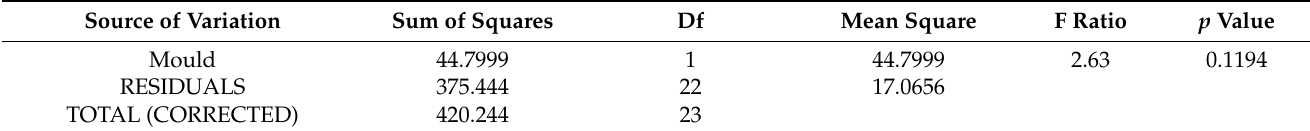
Table 14. ANOVA for PLA flexural strength (annealing temperature range 63–86 ◦ C).